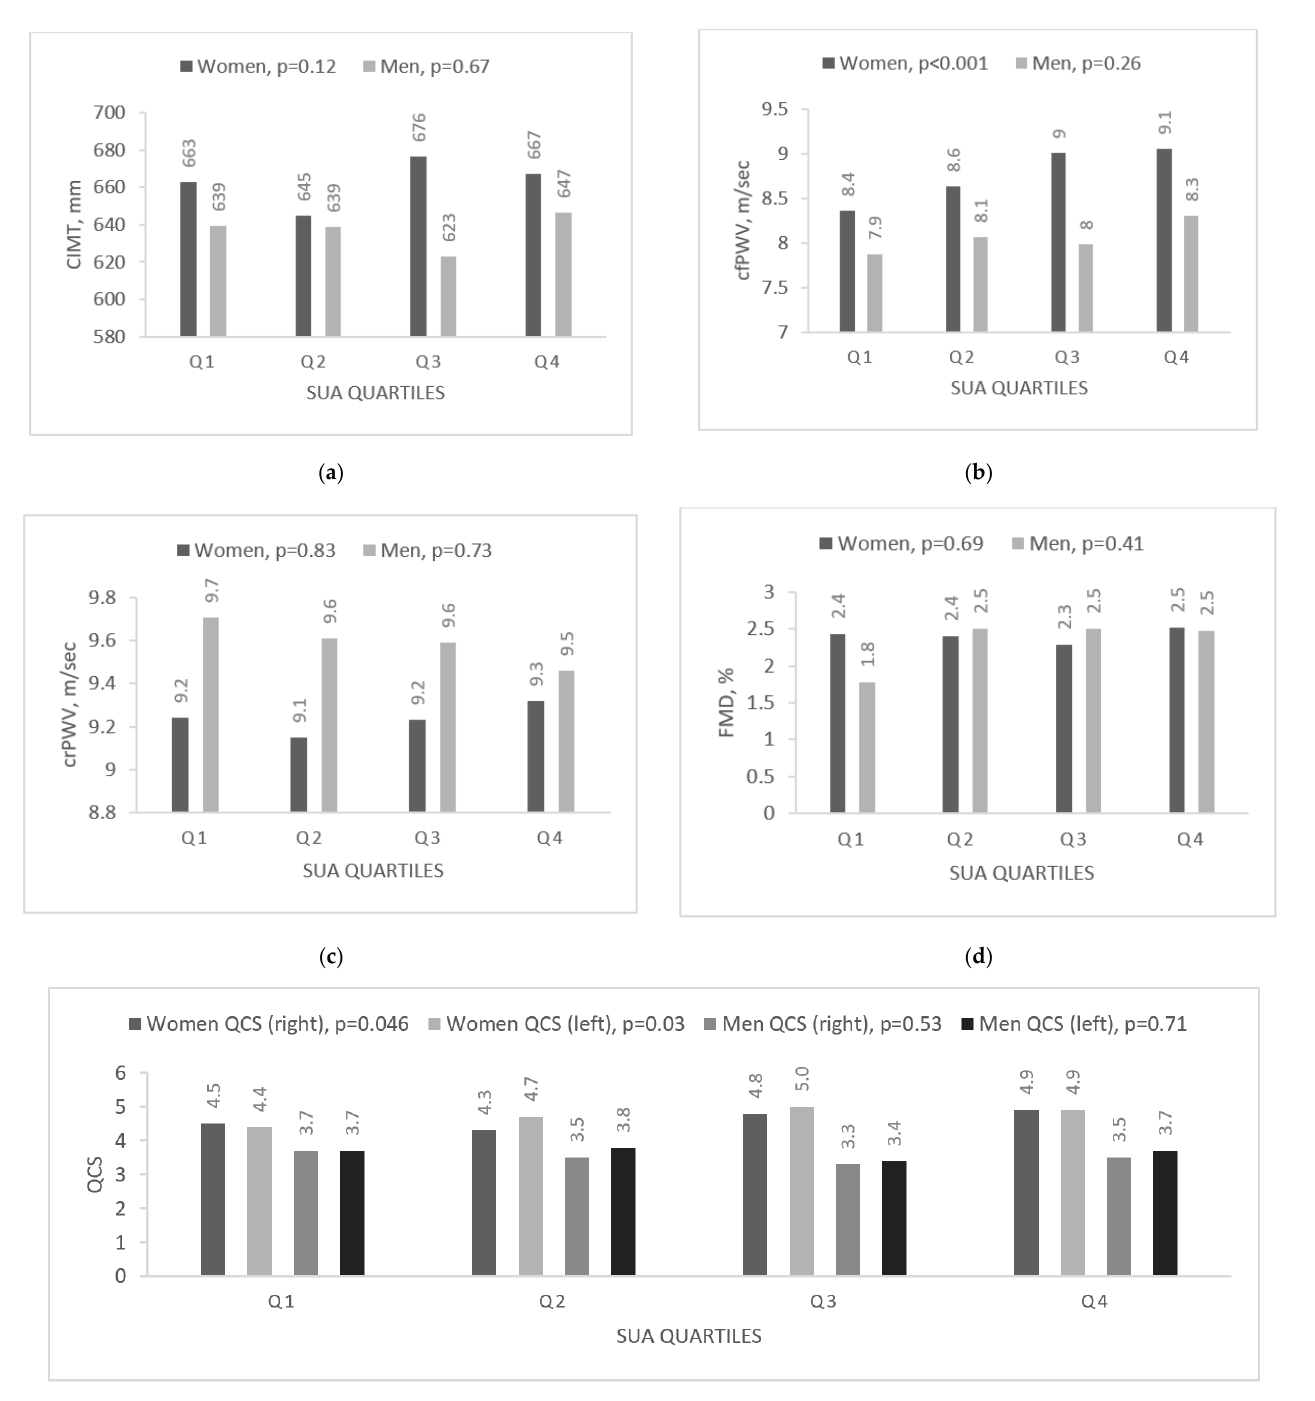
Figure 1. The comparison of arterial parameters by sex according to uric acid quartile: ( a – e ). CIMT, carotid intima-media thickness; cfPWV, carotid-femoral pulse wave velocity; crPWV, carotid-radial pulse wave velocity; QCS, quality carotid stiffness; SUA, serum uric acid.